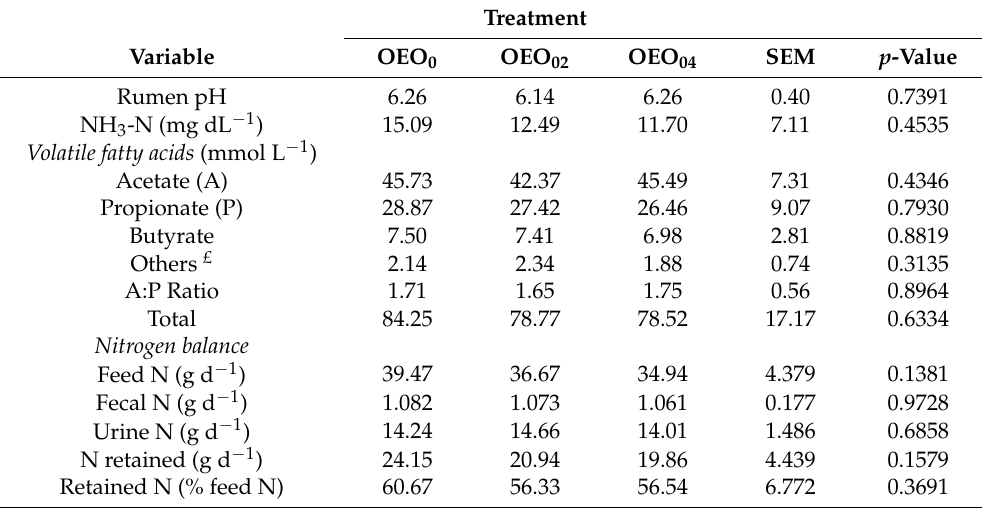
Table 3. Ruminal variables and nitrogen balance of lambs fed with different OEO levels in the diet.